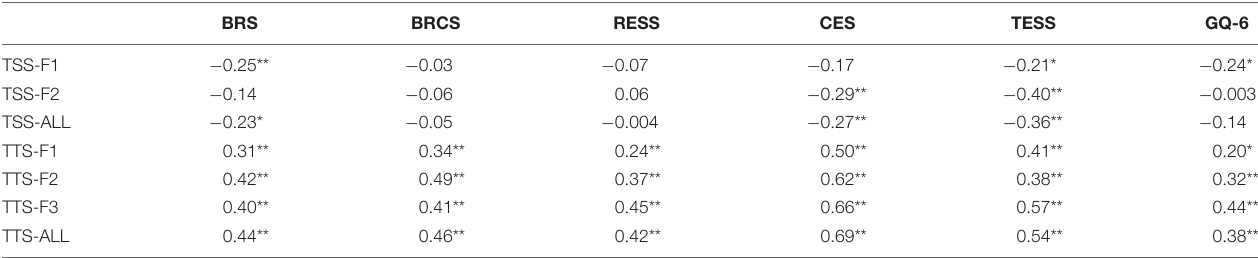
TABLE 9 | Pearson correlation coefficients for the TTS convergent